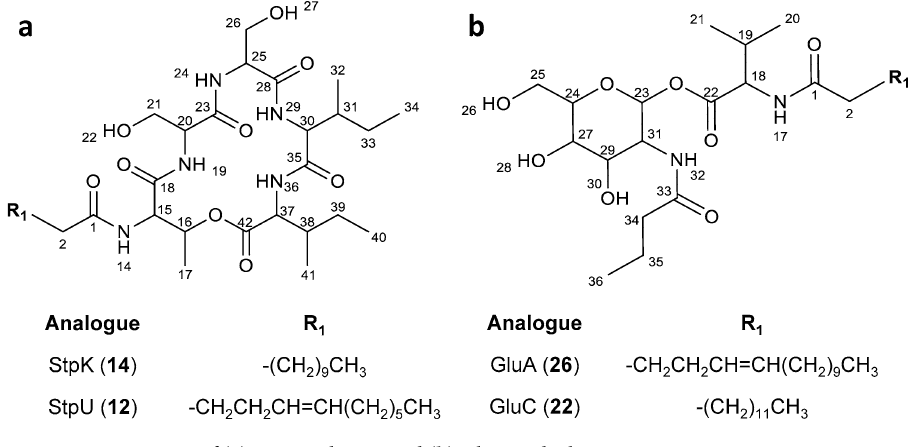
Figure 3. Structures of ( a ) StpK and StpU and ( b ) GluA and